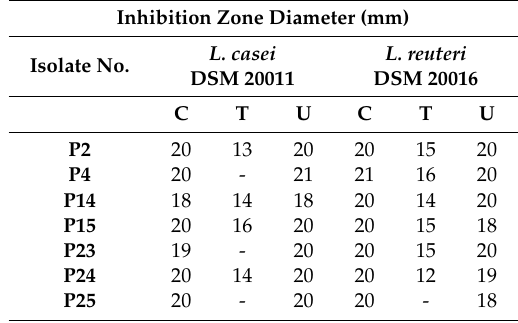
Table 2. Antimicrobial activities of L. casei and L. reuteri against P. mirabilis